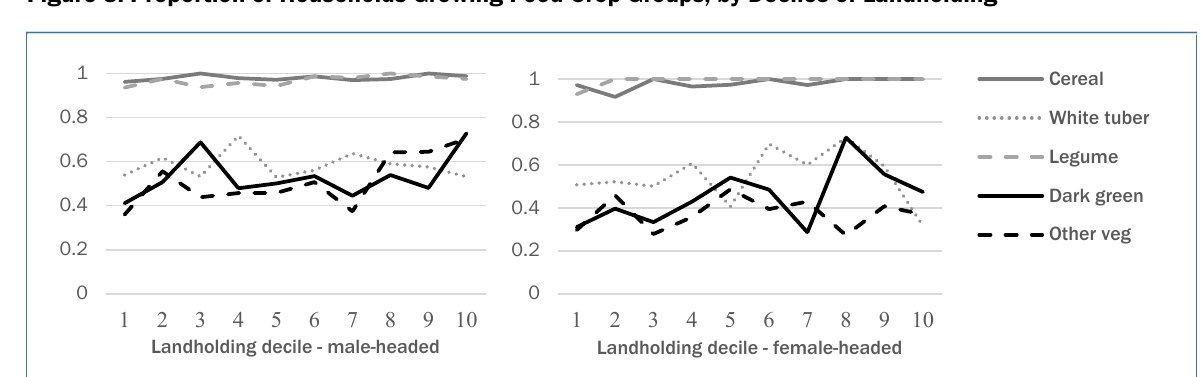
Figure 3. Proportion of Households Growing Food Crop Groups, by Deciles of